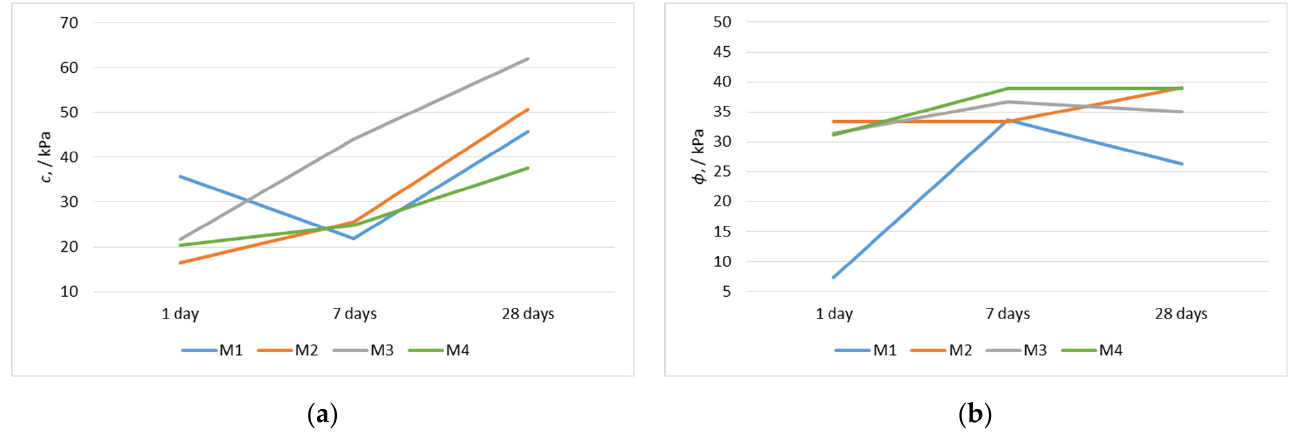
Figure 11. Cohesion and internal friction angle values change with specimen age, samples M1–M4 (influence of soil composition): ( a ) cohesion; ( b ) internal friction angle.